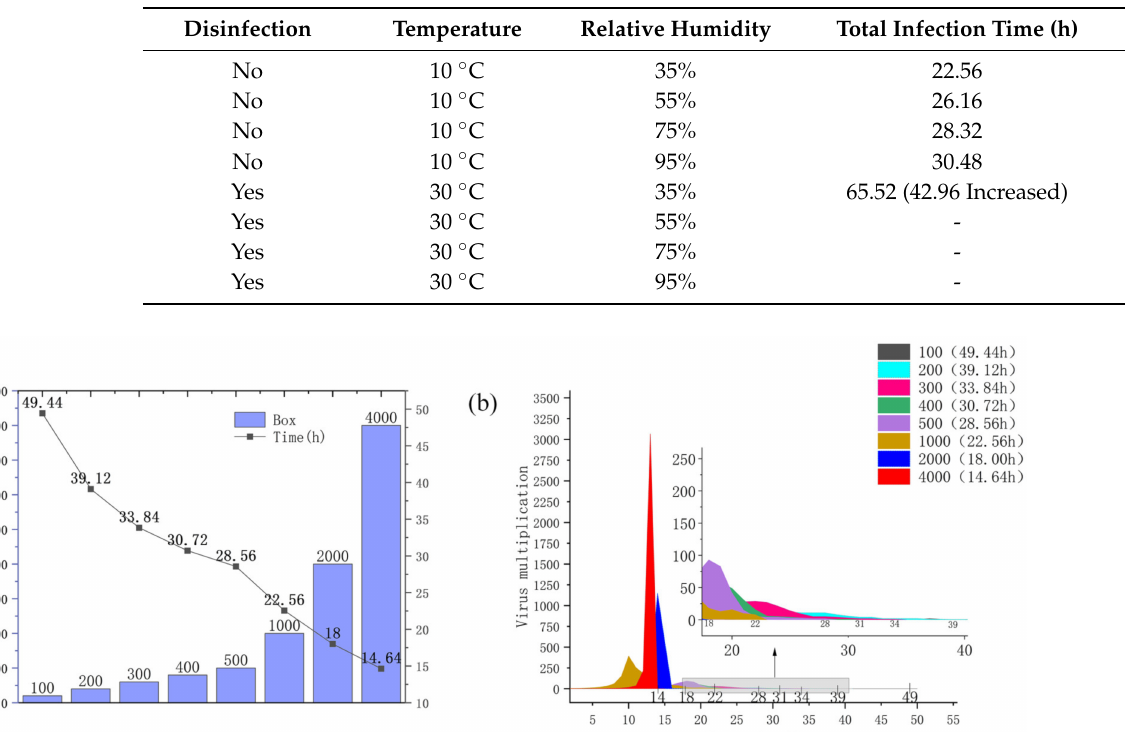
Table 3. Effect of relative humidity variation on virus transmission in express boxes (If the number of infections is <10, it is denoted by ‘-’).